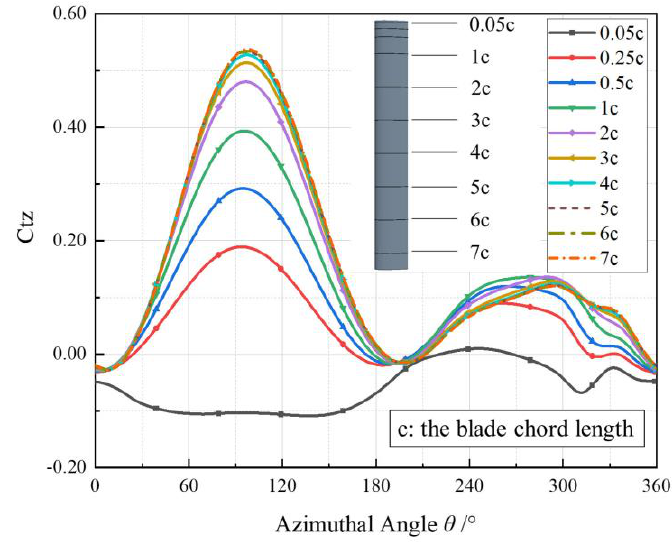
Figure 10. Instantaneous torque of sections at different heights during a rotation.